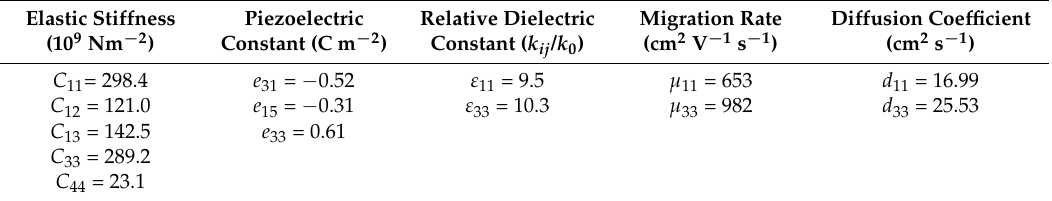
Table 1. Material parameters of polarized GaN piezoelectric semiconductor ceramics